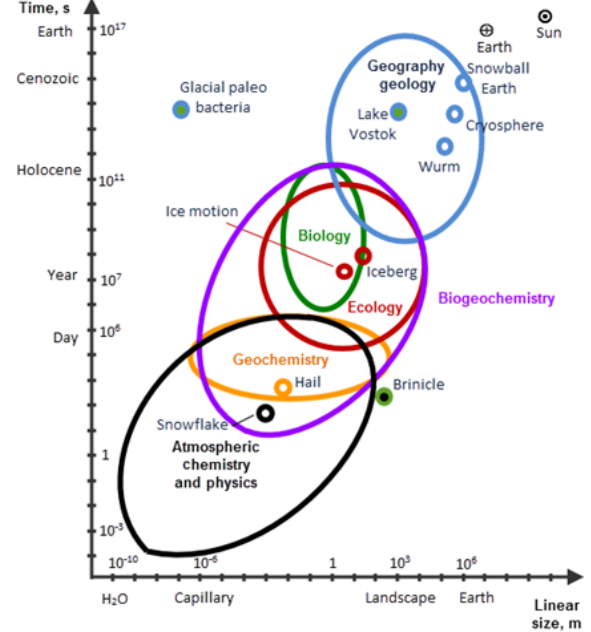
Figure 4. Log–log space-time diagram of cryogenic phenomena of different nature. Large ellipses or circles with different colours identify various sciences. Small circles show various objects of the cryosphere. The Earth and the Sun are shown to illustrate the range of